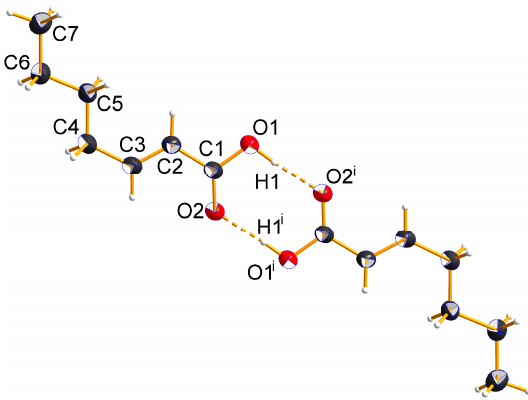
Figure 2. View of acid dimer molecules in the crystal of C7 showing the atom-labeling scheme. Displacement ellipsoids are drawn at the 50% probability level.